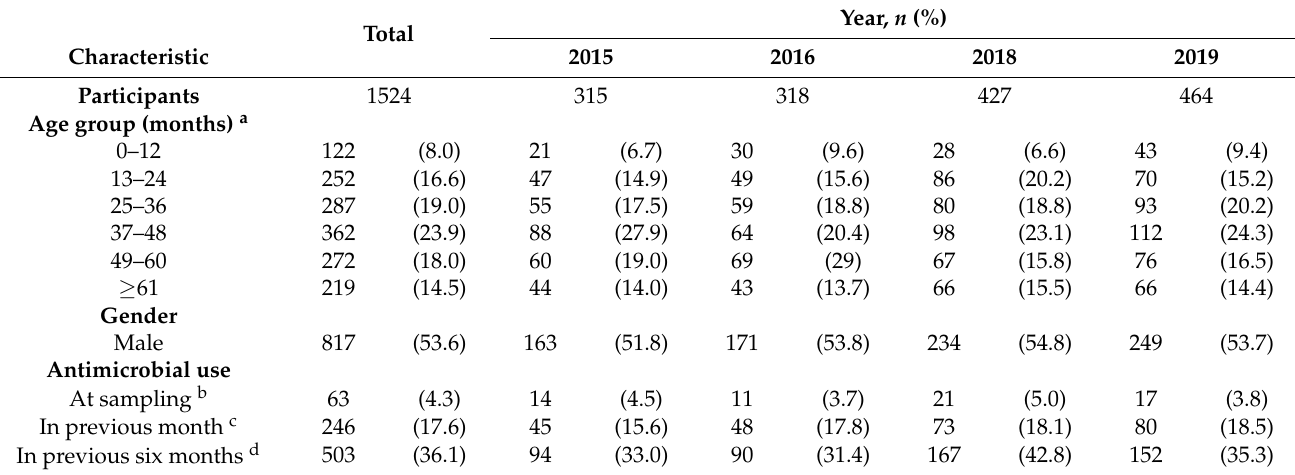
Table 1. Characteristics of population